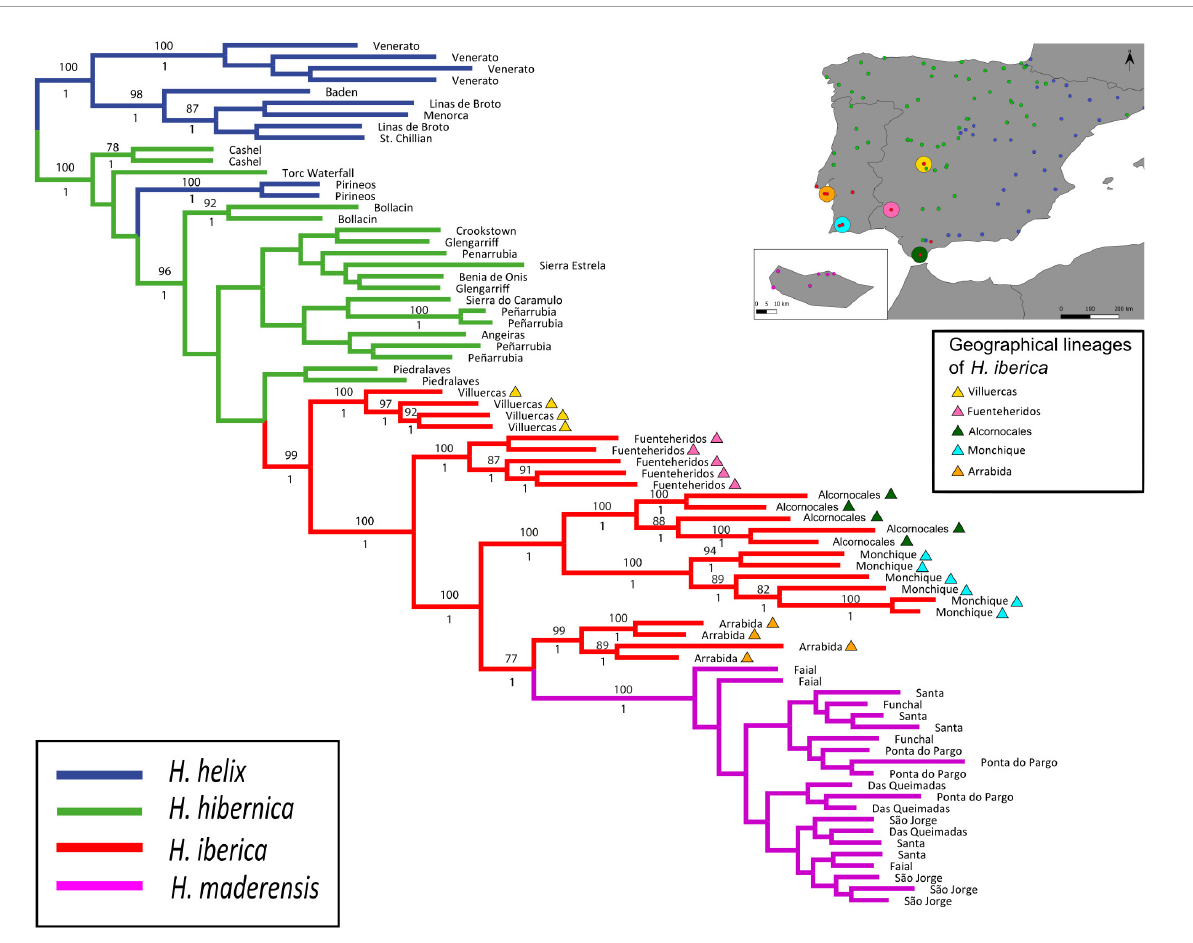
FIGURE2 Phylogenetic tree of the western polyploid clade of Hedera based on phylogenomic analysis of GBS data (c80m15p6r3) , and using H. helix as outrgoup. The maximum-likelihood tree obtained in RAxML is shown, with bootstrap support values ≥ 75% indicated above branches. Posterior probability values obtained in the Bayesian analysis in ExaBayes are shown below branches. The inset shows a map of the Iberian Peninsula and Madeira indicating sampling localities for the study of functional traits and the geographical lineages of H. iberica